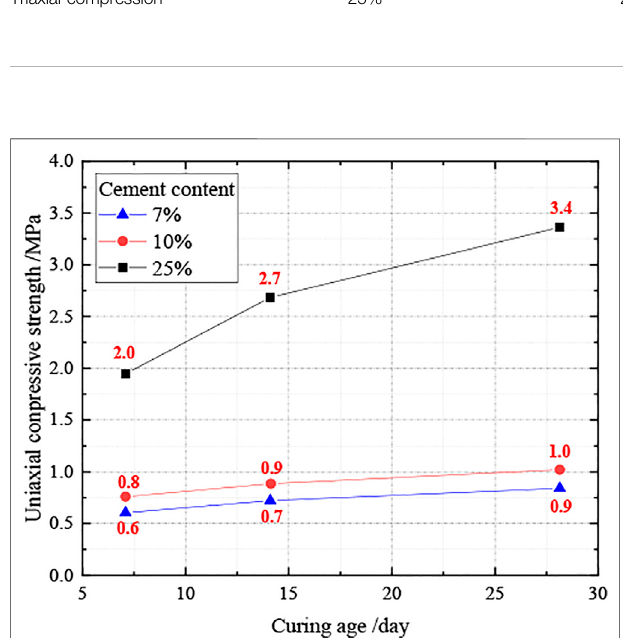
FIGURE 2 | Relationship curve between uniaxial compressive strength and curing